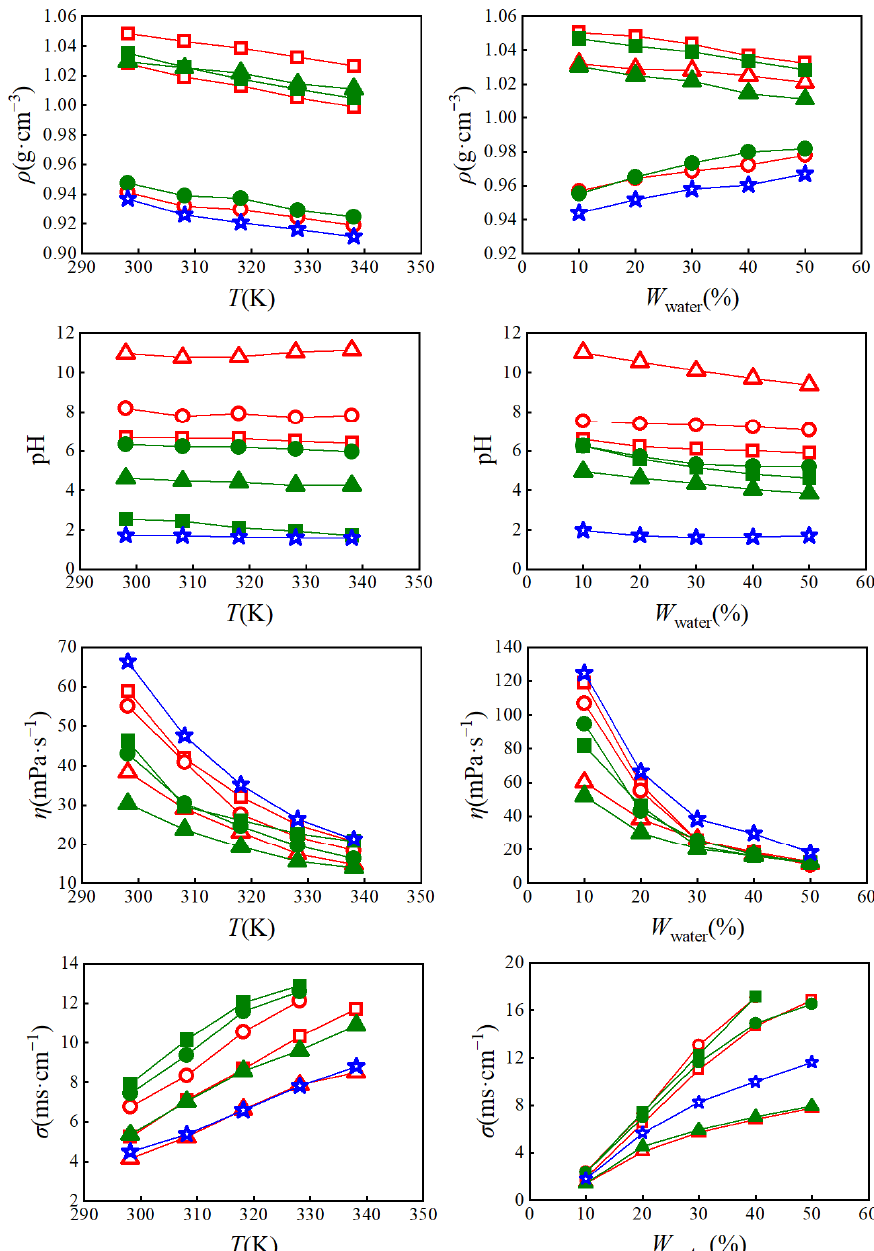
Figure 1. Effect of temperature ( left , w water = 20%) and water content ( right , T = 298.15 K) on the density, pH, conductivity, and viscosity of the IL aqueous solutions: ( □ )[N 4444 ]Br, ( ○ )[N 4444 ]Cl,